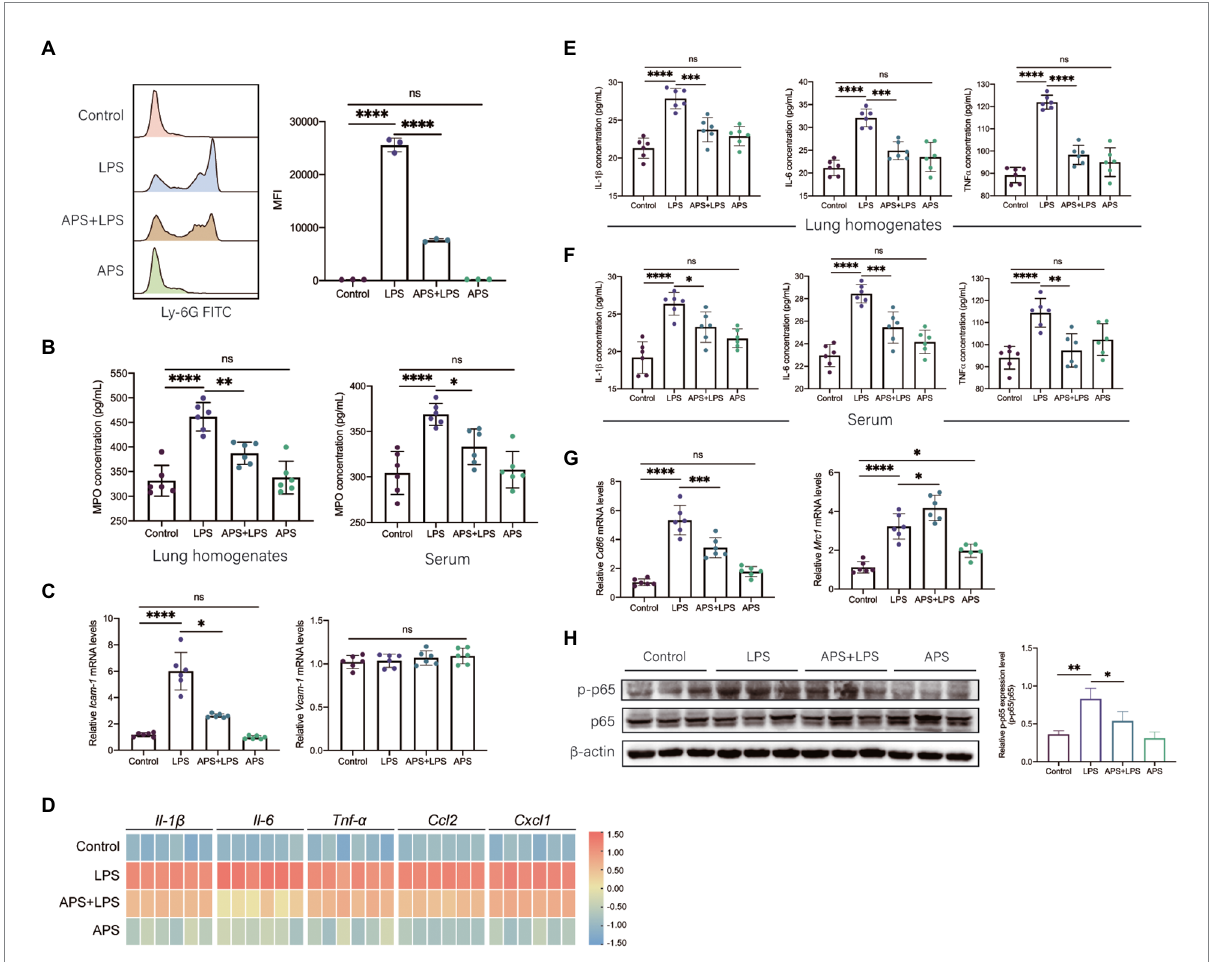
FIGURE 3 APS inhibited the inflammatory response induced by LPS. (A) The number of neutrophils in BALF was measured by flow cytometry. Representative flow cytometry histograms showing mean fluorescence intensity (MFI). MFI values were quantified n = 3 samples per group. (B) The myeloperoxidase (MPO) concentrations in lung homogenates and serum were measured by ELISA with n = 6 sample per group. (C) The mRNA expression levels of Icam-1 and Vcam-1 with n = 6 sample per group. (D) The heatmap represents the mRNA expression levels of pro-inflammatory genes in lung tissues with n = 6 samples per group. The relative expression data were normalized by using log scale and column scale and the heatmap was drawn in TBtools software. (E) The concentration of representative pro-inflammatory cytokines (IL-1 β , IL-6, and TNF- α ) in lung homogenates with n = 6 samples per group. (F) The concentration of representative pro-inflammatory cytokines (IL-1 β , IL-6, and TNF- α ) in serum with n = 6 samples per group. (G) The mRNA expression levels of M1 macrophages marker (Cd86) and M2 macrophages marker (Mrc1) in lung tissues with n = 6 samples per group. (H) The relative p-p65 expression level in lung tissue was presented by the ratio of p-p65 to p65 with n = 3 samples per group. High expression of p-p65 represents the activation of NF- κ B signals in lung. Statistical significance was determined by one- way ANOVA using GraphPad Prism 8 software. * p < 0.05, ** p < 0.01, *** p < 0.001, **** p <